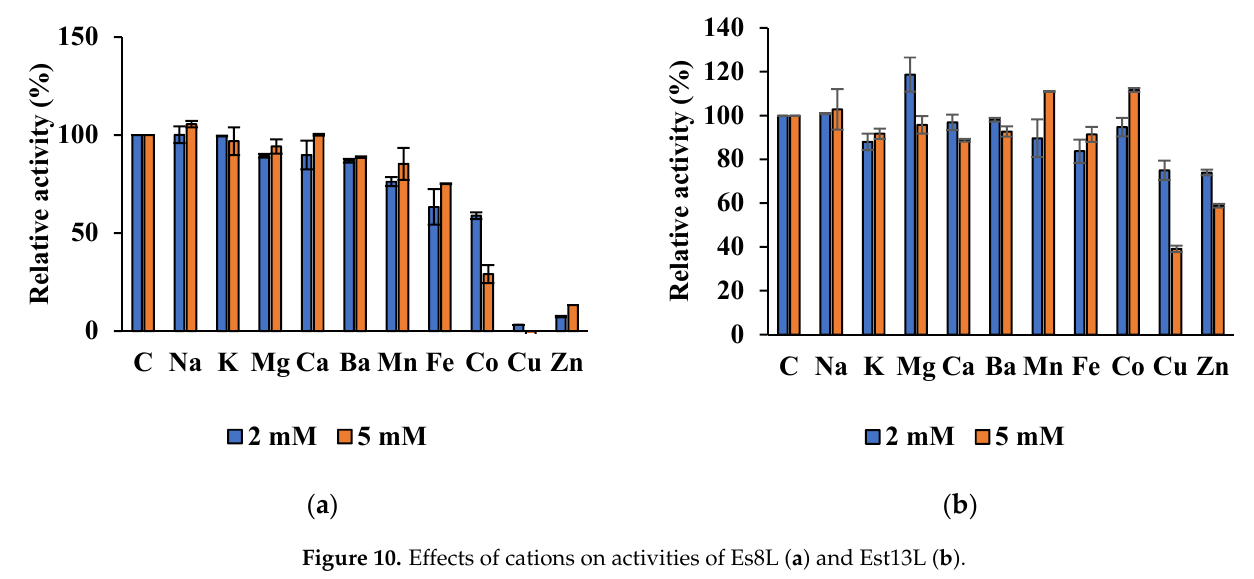
Figure 9. Effects of organic solvents, detergents, and inhibitors on the activities of Est8L ( a ) and Est13L ( b ). The activity was measured using an esterase assay with pNPB as a substrate. Est8L was significantly inhibited to 0%, 13.2%, and 29.0% at 5 mM Cu 2+ , Zn 2+ , and Cu 2+ , respectively, whereas Est13L was not significantly inhibited by most ions tested, except moderate inhibitions to 39.1% and 58.8% at 5 mM Cu 2+ and Zn 2+ , respectively (Figure 10).